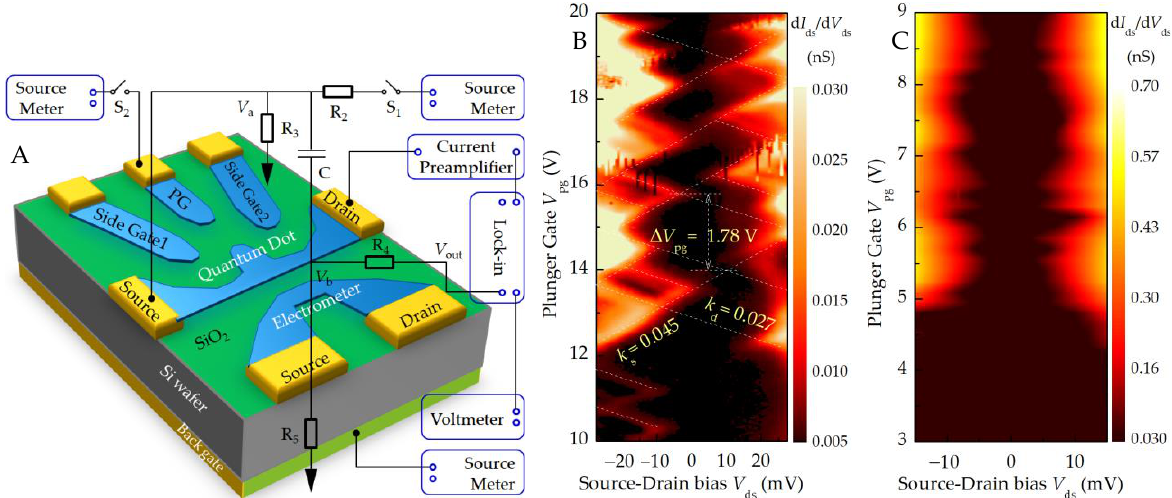
Figure 7. ( A ) AC phase-locked differential conductance current amplification test circuit. Differential conductance diagram of ( B ) the single-electron transistor and ( C ) nanostrip integrated with quantum dots measured at 2.7 K liquid helium temperature.